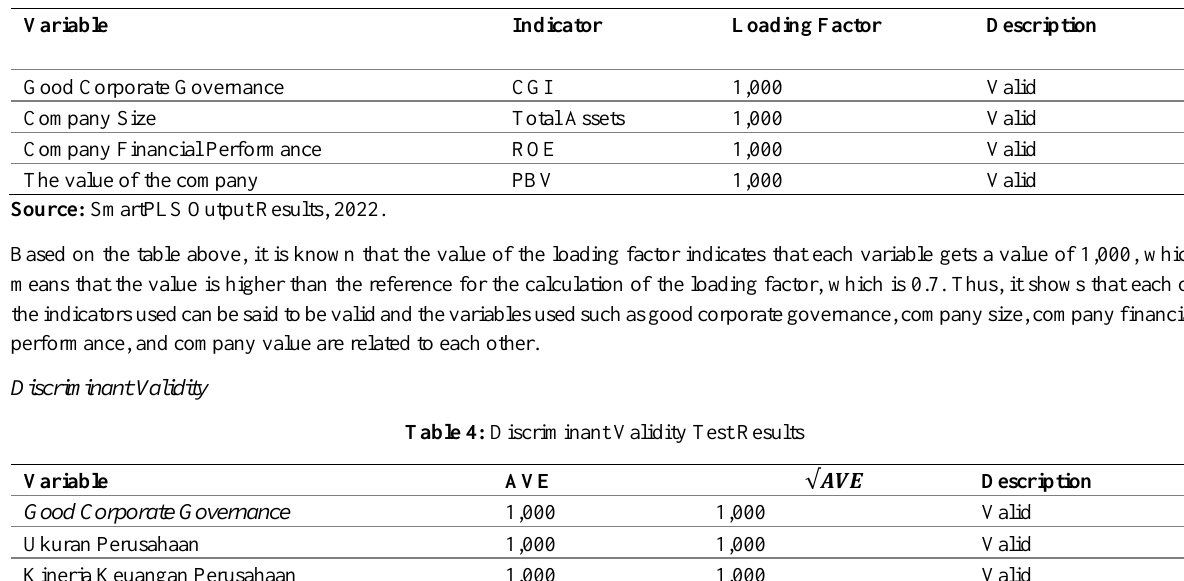
Table 3 : Convergent Validity Test Results